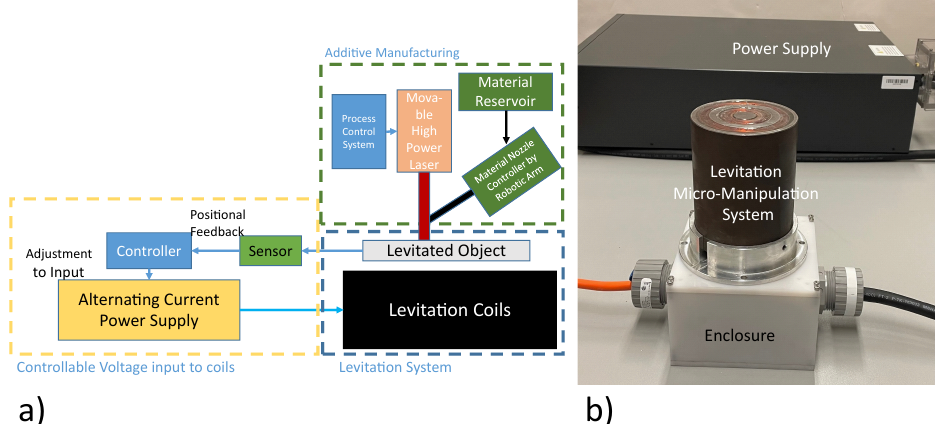
Figure 1. Micromanipulator levitation system. ( a ) Schematic for the envisioned system. ( b ) Experi- mental